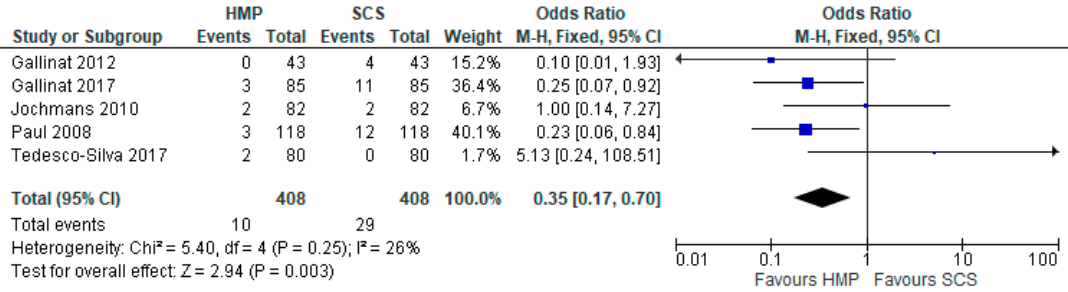
1 Table 7. Risk of bias assessment of studies comparing NMP and SCS in liver. Study